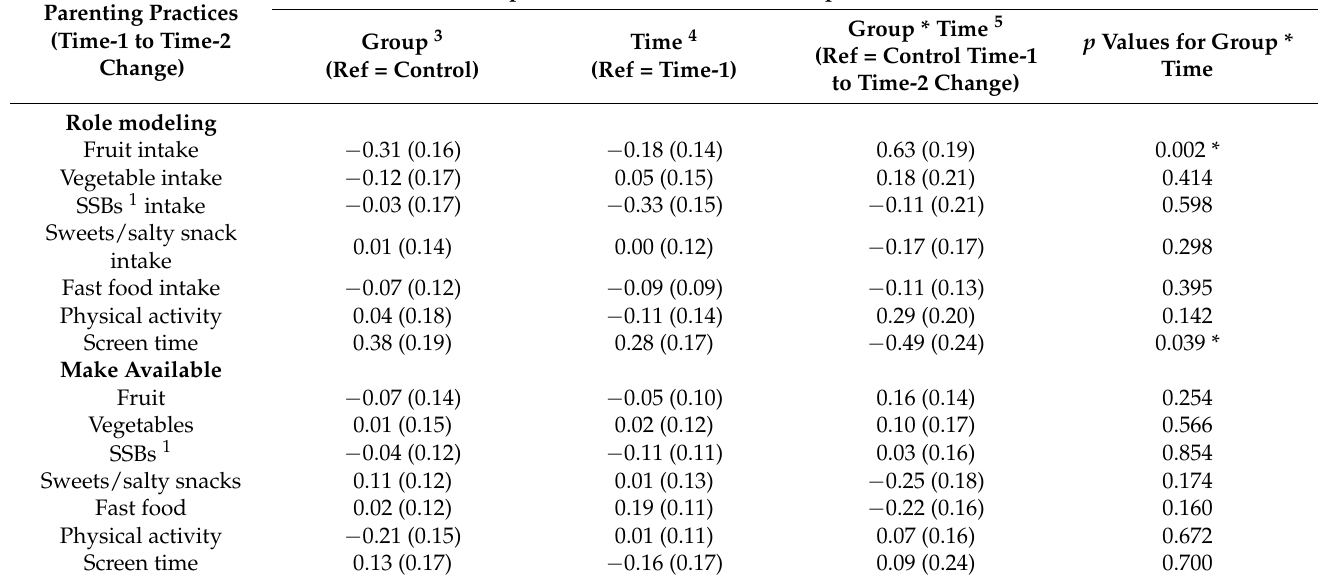
Table 4. Adjusted group differences for Time-1 to Time-2 change in paternal food and activity parenting practice